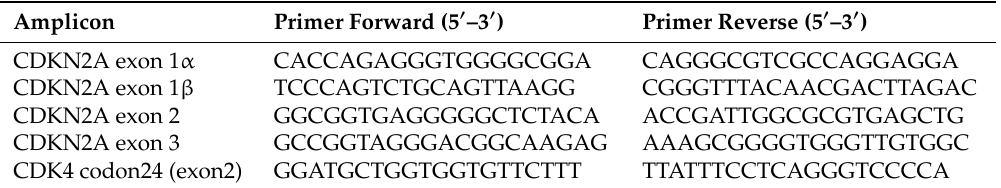
Table 1. Primer sequence for PCR amplification and Sanger sequencing of CDKN2A gene and CDK4 codon 24